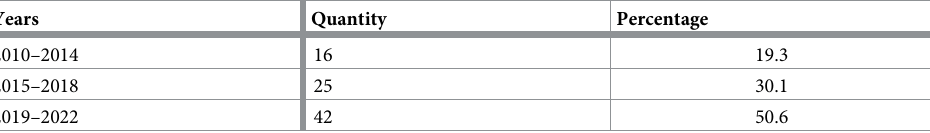
PLOS ONE | https://doi.org/10.1371/journal.pone.0283838 April 6,